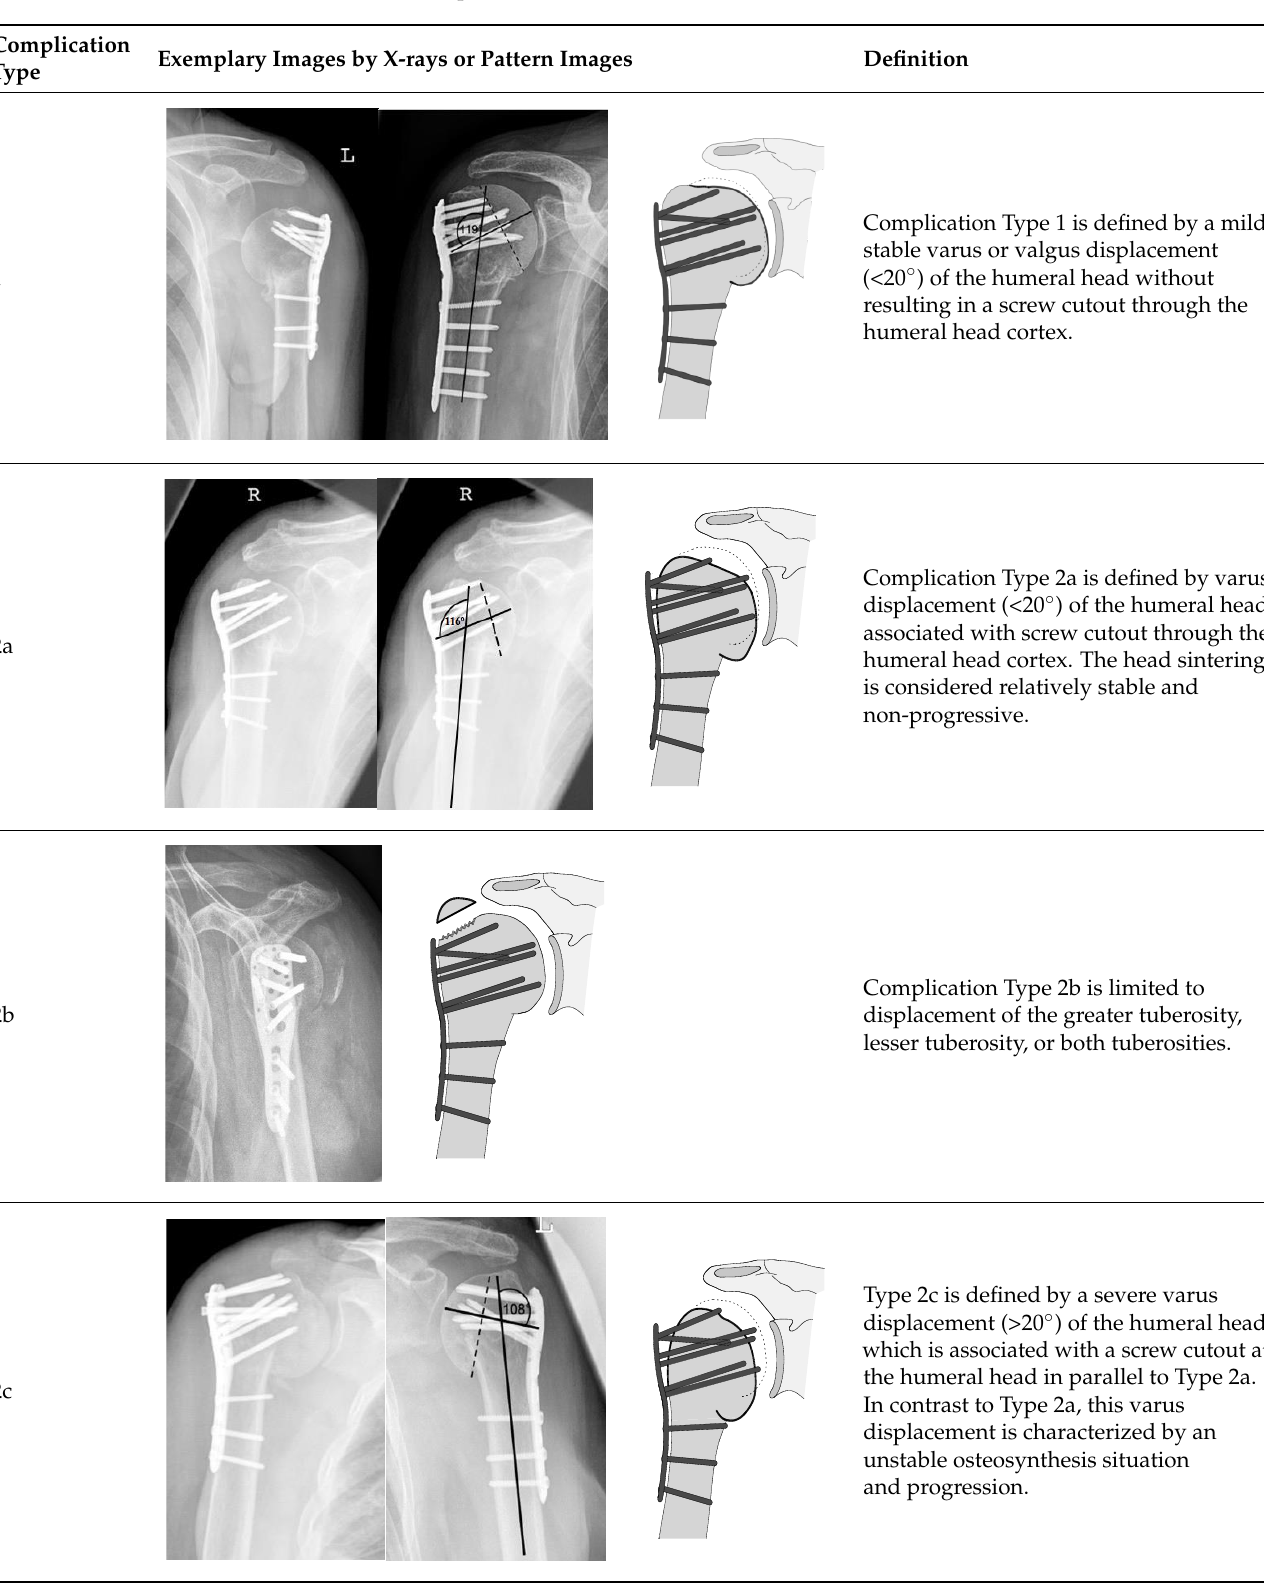
Table 1. Classification of complication types following locking plate osteosynthesis of displaced fractures of the proximal Humerus.